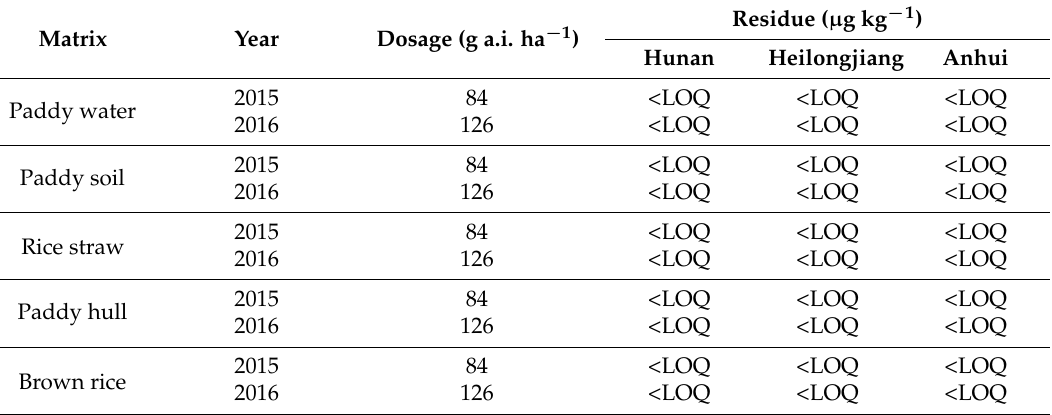
Table 5. Final residues of oxadiargyl in paddy water, paddy soil, rice straw, paddy hull and brown rice on the harvest